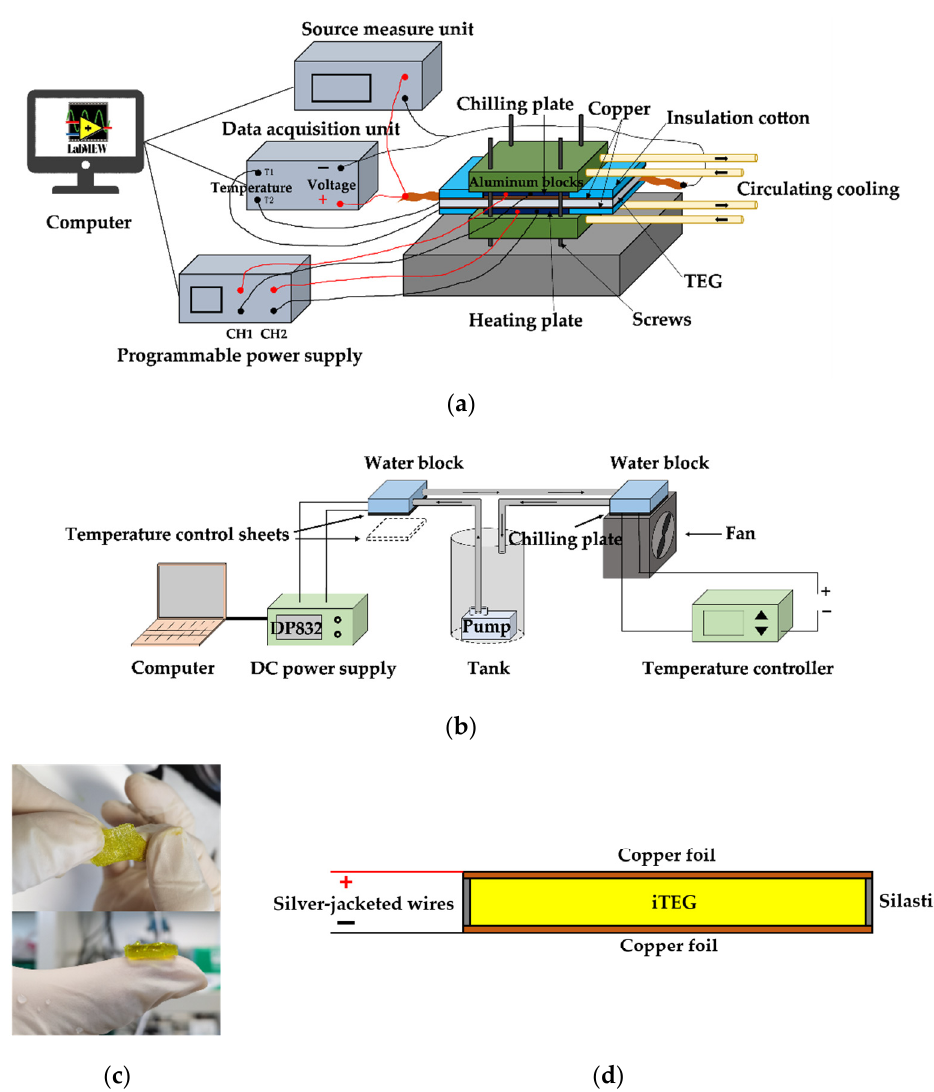
Figure 1. ( a ) Schematic diagram of the self-made TEG-testing platform; ( b ) schematic diagram of the two-stage circulating water-cooling system; ( c ) the jelly-like appearance of the iTEG block; ( d ) section diagram of the assembled TEG unit.